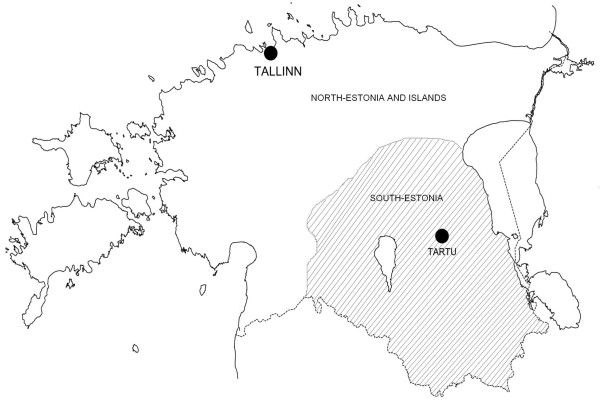
Physical map of Estonia (~45000 km2) and two recruitment centers: North-Estonian Regional Hospital, Tallinn representing Northern, North-Eastern, South-Western and Western (including largest islands) parts of Estonia; University of Tartu Clinics, Tartu, representing Central, South-Eastern and Southern parts of Estonia.